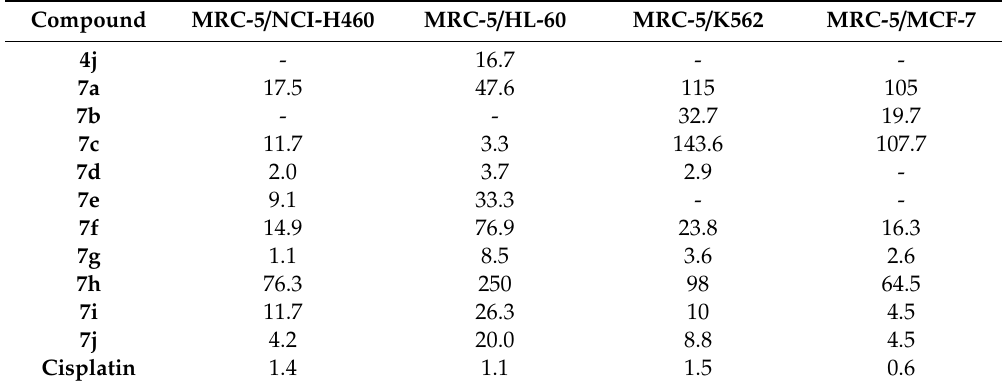
Table 2. Selectivity Index (SI) a values for the most active purine